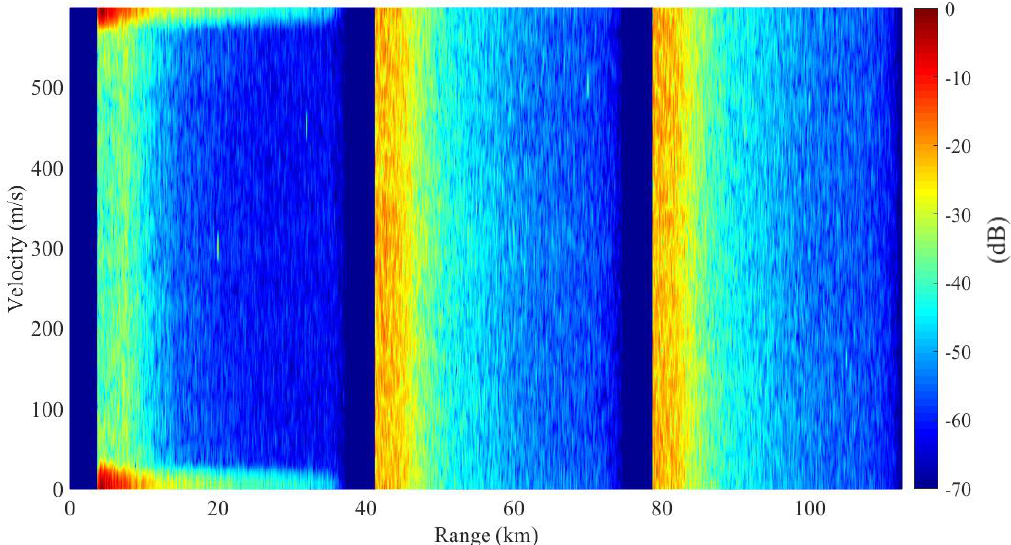
Figure 6. Range-Doppler resolution for traditional PD process using matched filters.